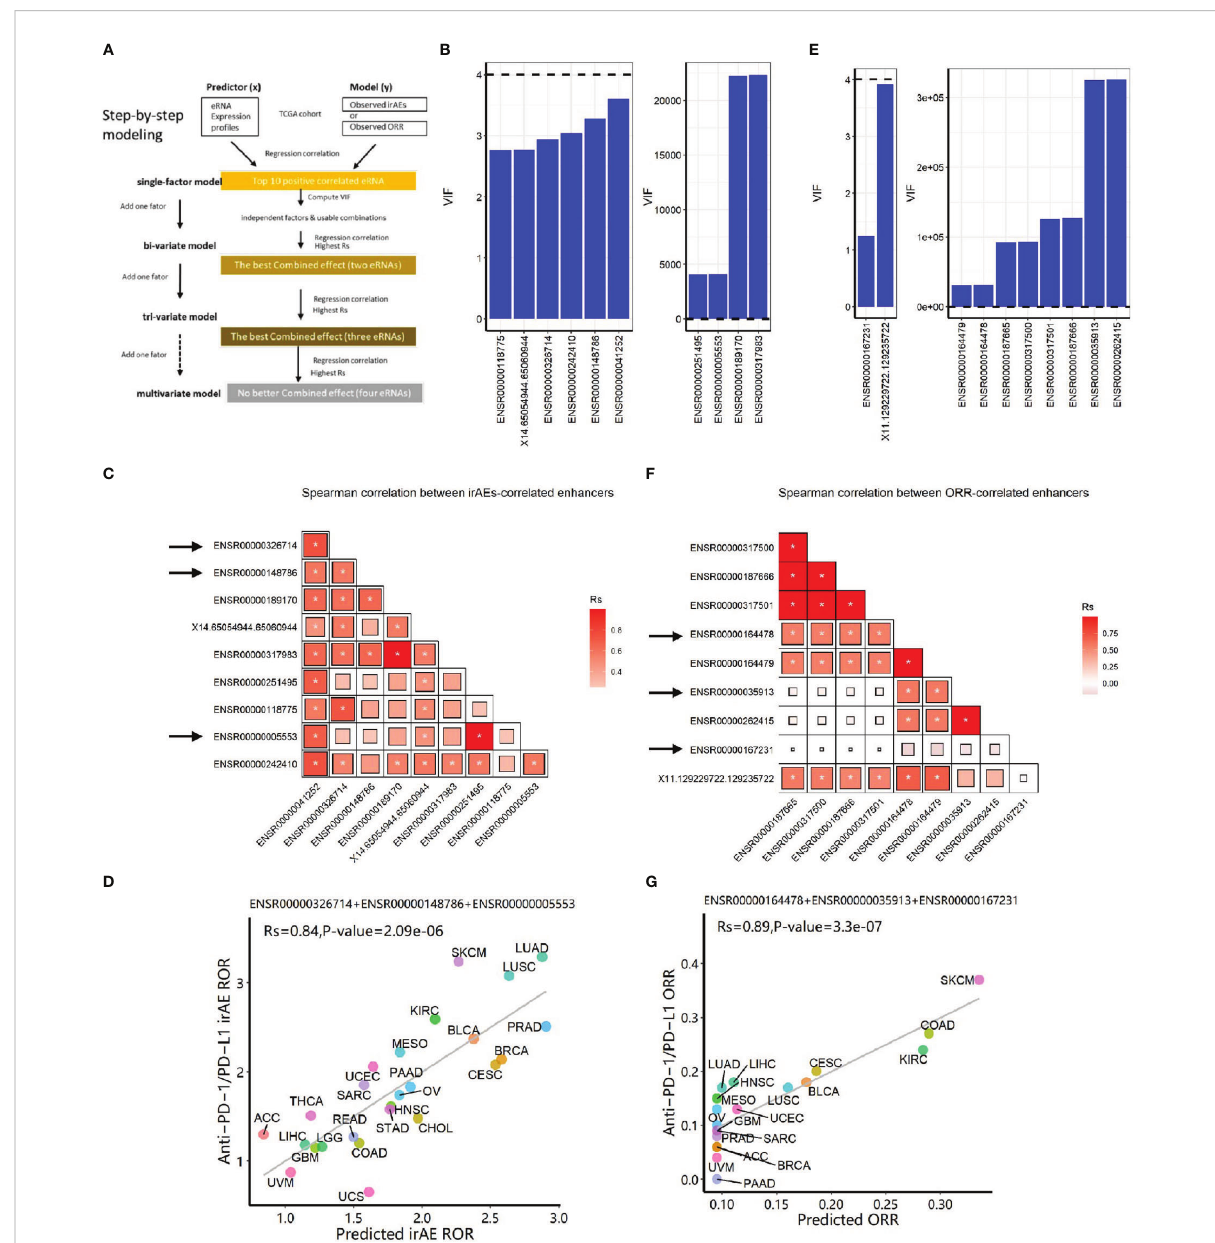
FIGURE 1 Construction of eRNA-based prediction models for irAE ROR (risk) and ORR (bene fi t) of immunotherapy. (A) The step-by-step work fl ow of this study. (B) Multicollinearity (VIF) analysis for top ten eRNA expression in predicting irAEs. Six eRNAs showed no multicollinearity, while 4 eRNAs showed strong multicollinearity. (C) Spearman correlation (Rs) between irAE-correlated eRNAs. The shade of the square indicates the Rs, and the size indicates signi fi cance (* indicates statistical signi fi cance P <0.05). (D) Combined effects of the fi nal trivariate model of predicting irAEs (R=0.84, P =2.1e-6). The model is 0.1912*ENSR00000005553+0.4097*ENSR00000326714+0.1953*ENSR00000148786+0.2942. (E) Multicollinearity analysis for top ten eRNA expression in predicting ORR. Two eRNAs showed no multicollinearity, while 8 eRNAs showed strong multicollinearity. (F) Spearman correlation between ORR-correlated eRNAs. The shade of the square indicates the Rs , and the size indicates P-value (* indicates statistical signi fi cance P <0.05). (G) Combined effects of the fi nal model of predicting ORR (R=0.89, P =3.3e-7). The model is 0.0953 + 0.0649*ENSR00000164478+0.0032*ENSR00000035913+0.1687*ENSR00000167231. irAE, immune-related adverse events; ROR, reporting odds ratio; ORR, objective response rates; LUAD, lung adenocarcinoma; SKCM, skin cutaneous melanoma; LUSC,